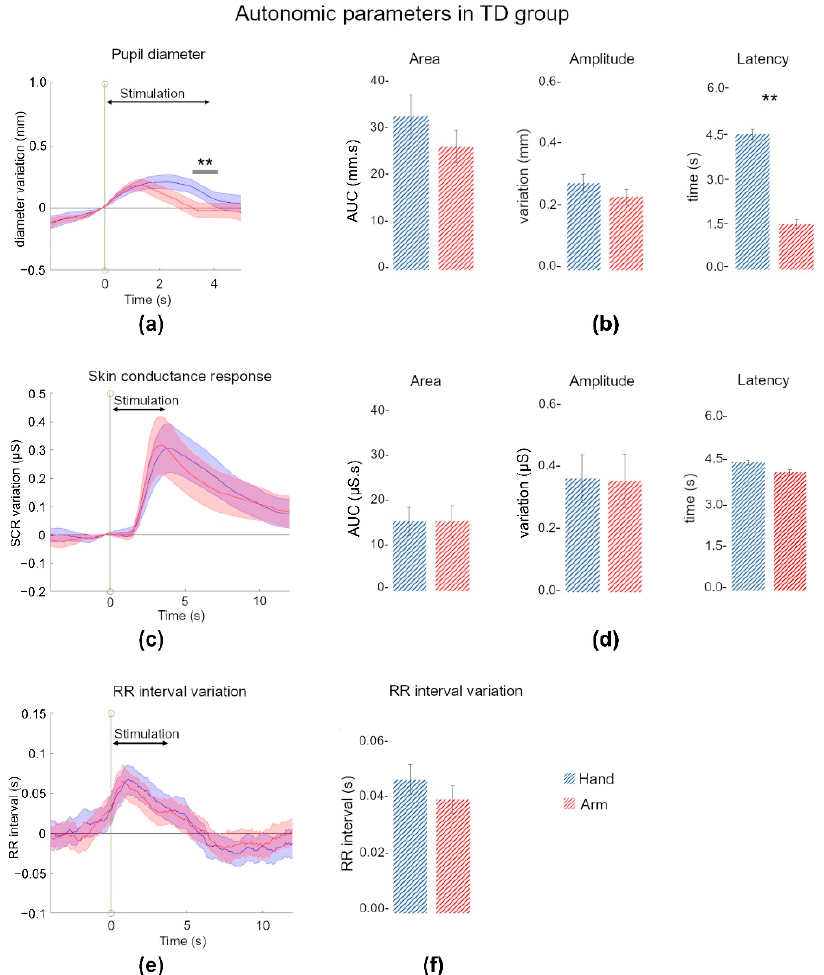
Figure 2. ANS responses to tactile stimulation in the total TD group. ( a ) Mean pupil dilation (relative to the baseline value, in mm) as a function of time during an arm stimulation (red) or a hand stimulation (blue). The shading around the curve corresponds to the SEM. The green vertical line (0 s) indicates the beginning of the stimulation. The continuous black line indicates the length of the stimulation. The continuous grey line indicates the significant difference between the two curves. ( b ) Mean values ( ± standard error) for the three pupil parameters extracted for the two stimulation conditions (arm in red, hand in blue): AUC (in mm.s), maximum amplitude (in mm), and latency of the maximum response (in s). ( c ) Mean SCR (relative to the baseline value, in µ S) as a function of time during an arm stimulation (red) or a hand stimulation (blue). Same conventions as in ( a ). ( d ) Mean values ( ± standard error) for the three skin conductance parameters calculated for the two conditions (arm in red, hand in blue): AUC (in µ S.s), maximum amplitude (in µ S), and latency of the maximum response (in s). ( e ) Mean RR interval (relative to the baseline value, in s) as a function of time during an arm stimulation (red) or a hand stimulation (blue). Same conventions as in ( a ). ( f ) Mean value ( ± standard error) of the RR interval (in s) calculated for the two conditions (arm in red, hand in blue). **: p <